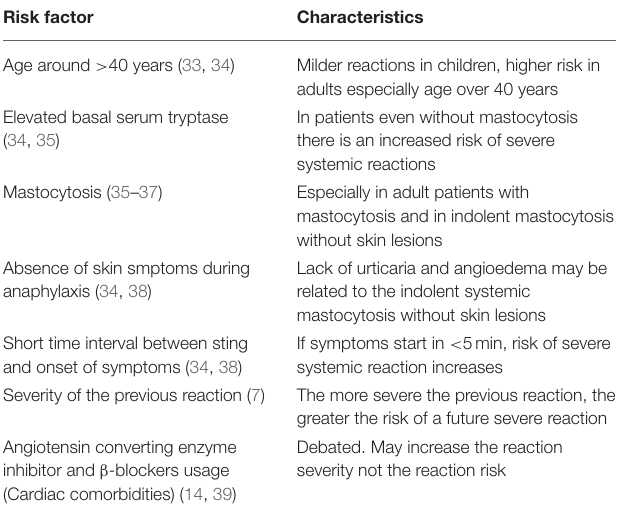
TABLE 1 | Risk factors for severe systemic reactions/anaphylaxis to hymenoptera